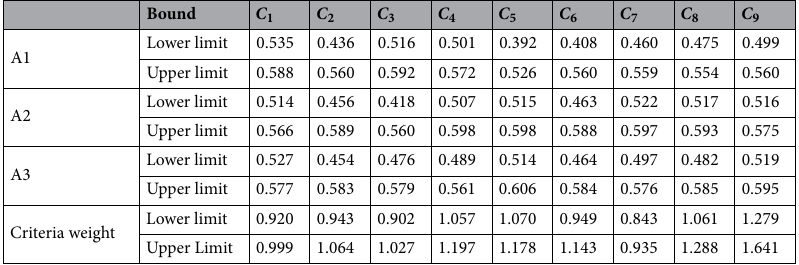
Table 9. The interval weight of criteria.